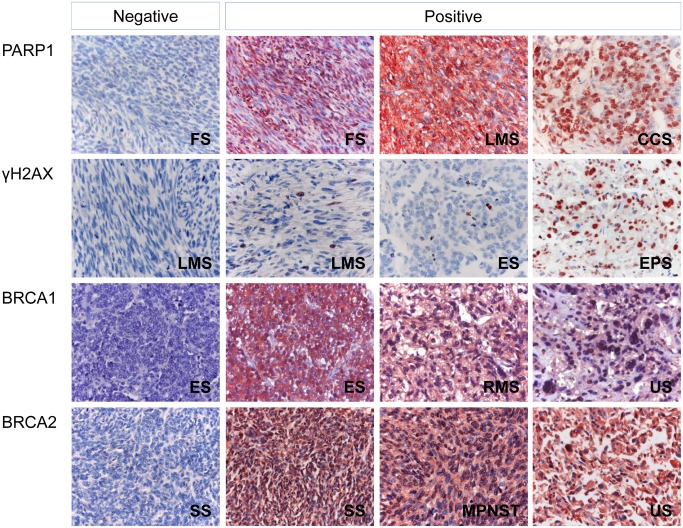
Immunohistochemical expression of PARP1, γH2AX, BRCA1, and BRCA2 in various soft tissue sarcomas.Abbreviations: FS, adult fibrosarcoma; LMS, leiomyosarcoma; MPNST, malignant peripheral nerve sheath tumor; ES, Ewing sarcoma; CCS; clear cell sarcoma; SS, synovial sarcoma; RMS, rhabdomyosarcoma; US, undifferentiated sarcoma. Original magnification, x400.